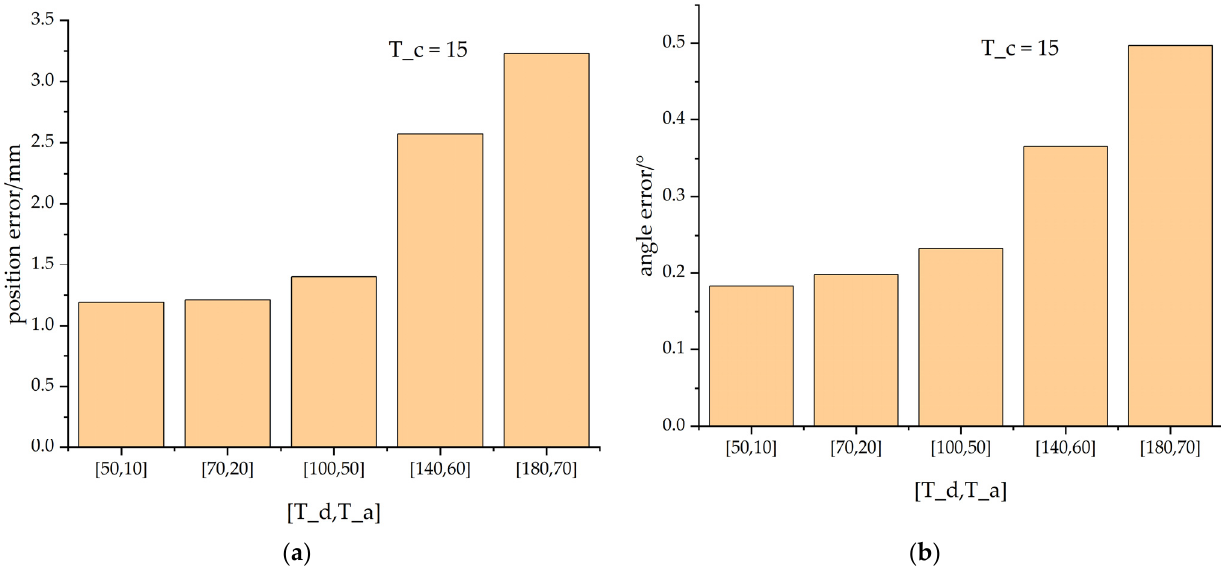
Figure 19. The pose errors resulting from different thresholds: ( a ) position error; ( b ) angle error.